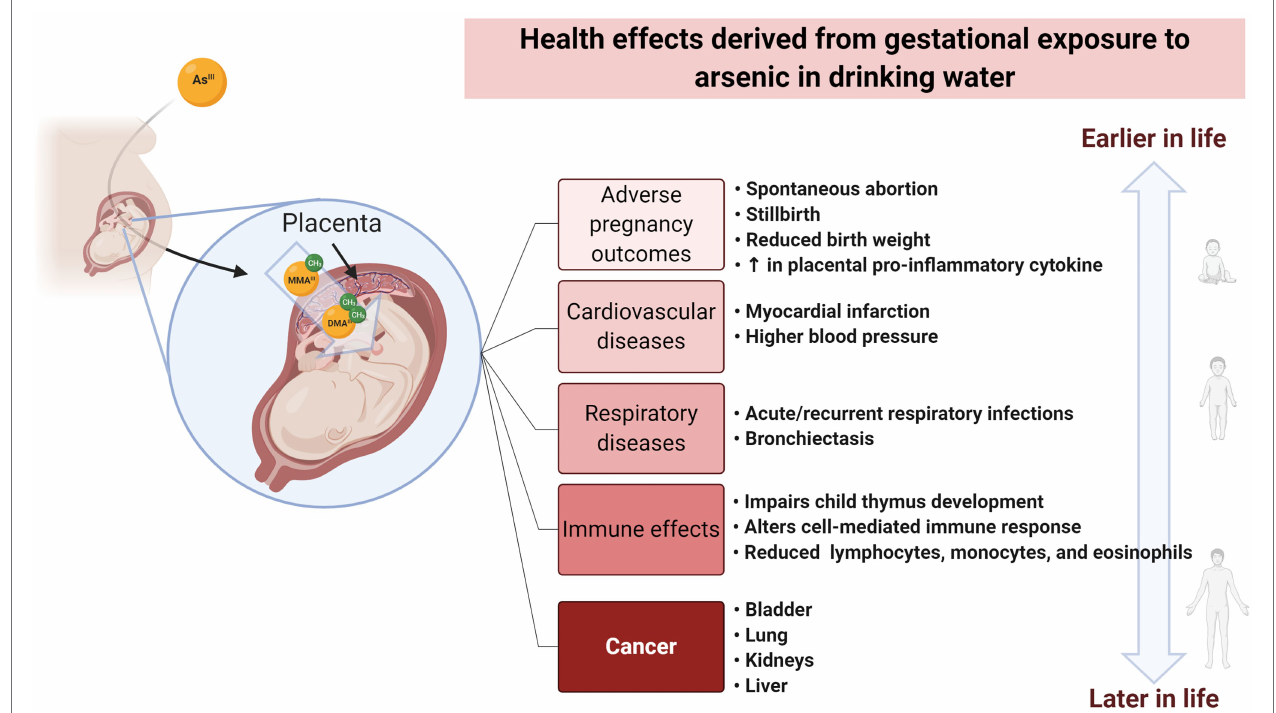
FIGURE 1 | Health effects derived from gestational exposure to arsenic in drinking water. Arsenic ingested by the mother can cross the placental barrier. Gestational exposure to arsenic has been associated with effects at pre-and perinatal stages, as well as during childhood. These effects include adverse pregnancy outcomes and alterations to the cardiovascular, respiratory, and immune system. Moreover, in utero exposure has been correlated with an increased risk of developing cancer and other types of diseases during the adult life. Created with